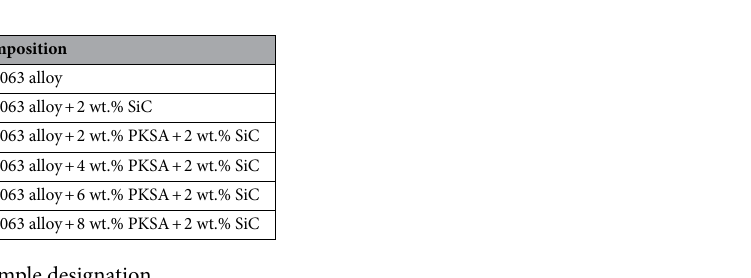
Table 2. Composite sample